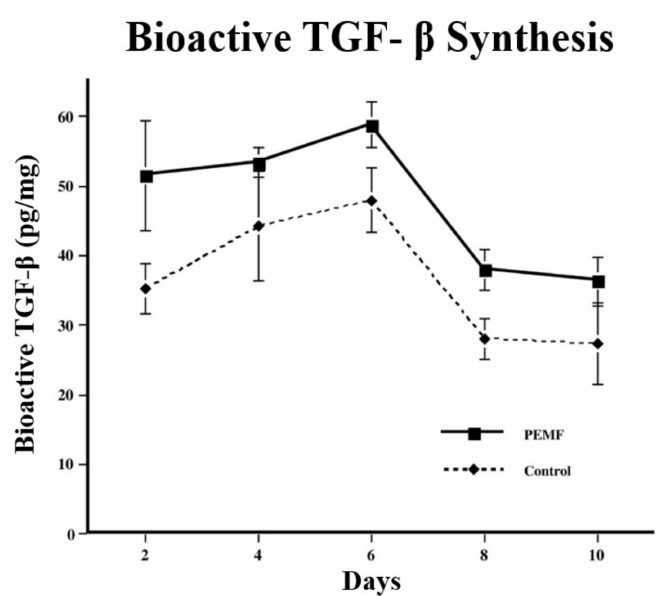
Figure 9. Increase in bioactive TGF- β protein (pg/mg ossicle) with PEMF stimulation. Significant increases are seen at days 2, 6, and 8 of development (<0.05). TGF- β protein is increased in pre- chondrogenic and early chondrogenic tissue with a decrease on day 8 just prior to matrix calcification. The constitutive pattern of TGF- β expression is increased but not disorganized. Adapted with permission from Ref. [11]. 2006, Annals of the New York Academy of Sciences